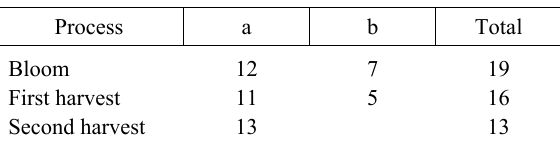
Table 1. The number of phenological observations by type.